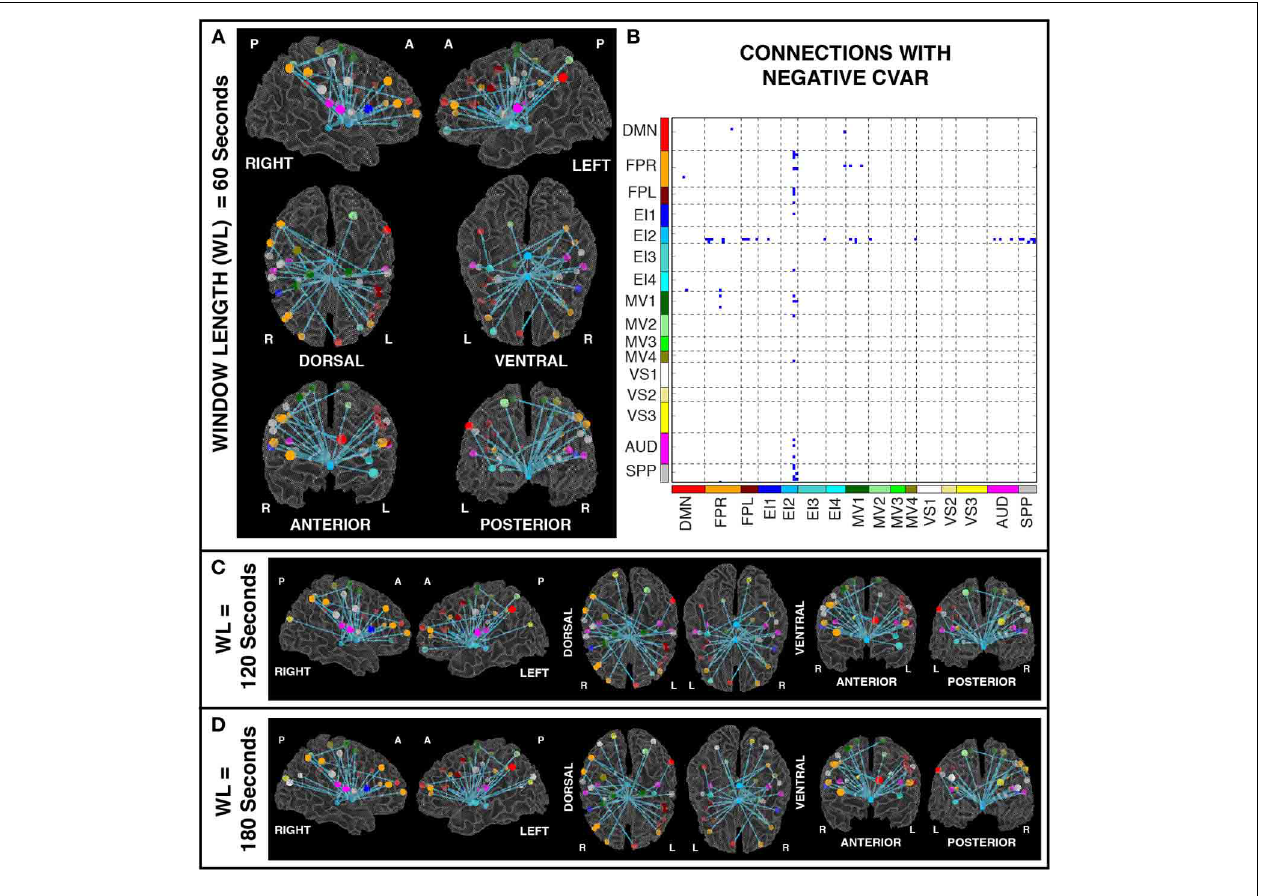
FIGURE 11 | (A) Negative CVAR connections for window length = 60s. Connections with negative CVAR in all 11 participants are shown over 3D renderings of a brain surface. (B) The same information shown as a 2D matrix. Colors corresponding to networks